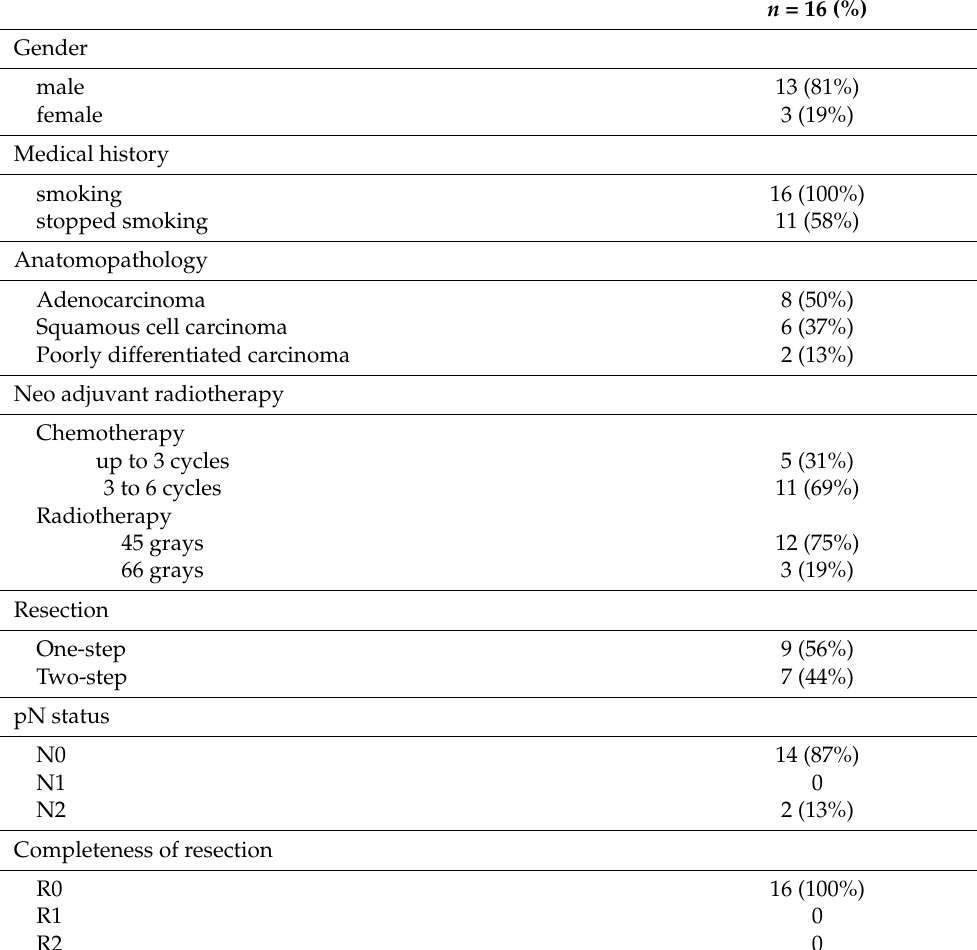
Table 1. Patients